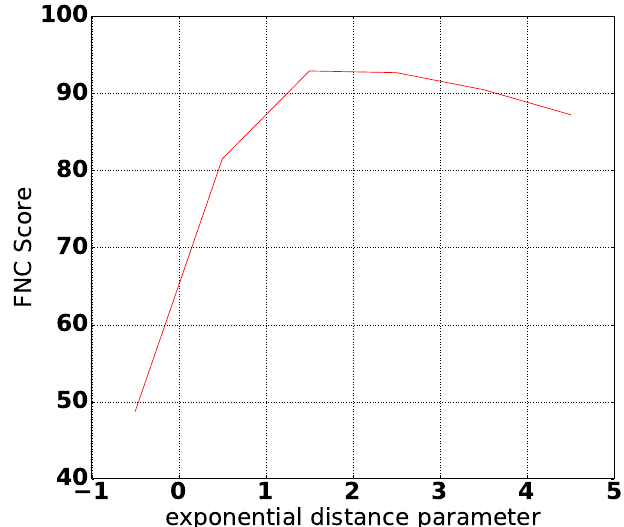
Figure 4. Exponential distance parameter and performance of the model.